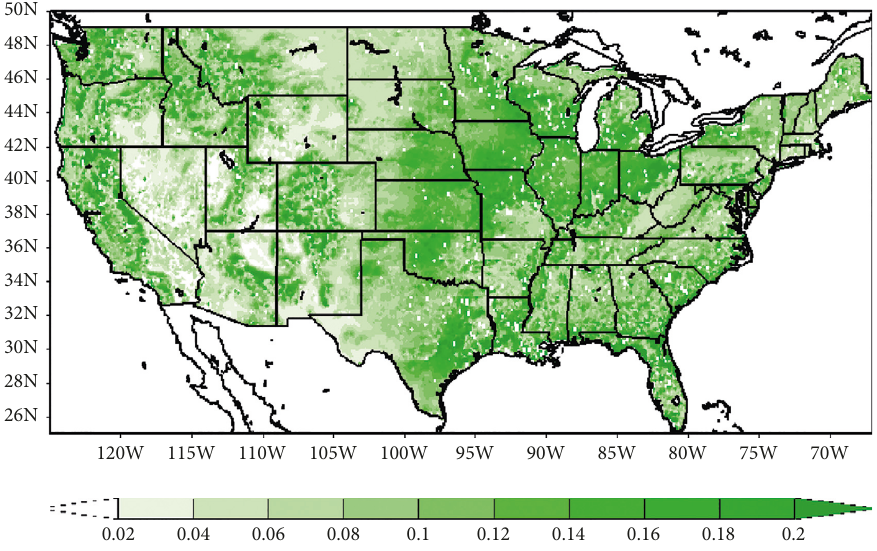
Figure 1: RMSD between climatological and NRT GVF over 2000–2012